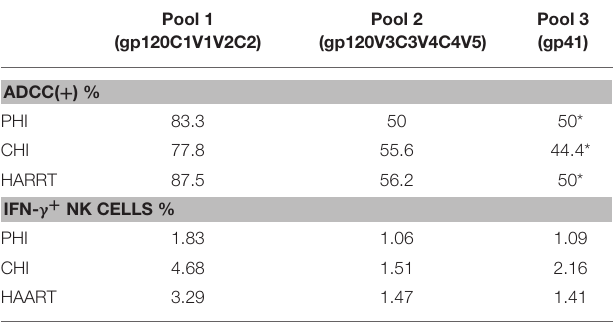
TABLE 2.2 | Mapping HIV-specific antigen epitopes in CHI group. Total responders Peptide no. Sequence